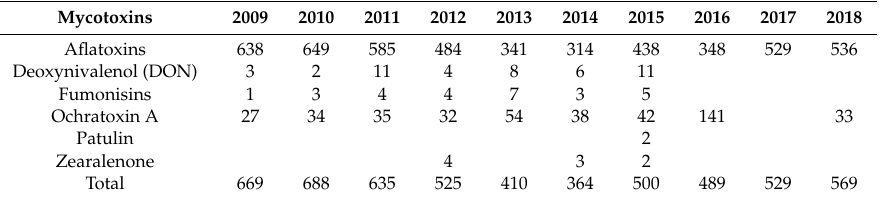
Table 2. Mycotoxin notification in the EU during the decade 2009–2018 (Rapid Alert System for Food and Feed (RASFF), Annual Report, 2009–2018) [23–32].